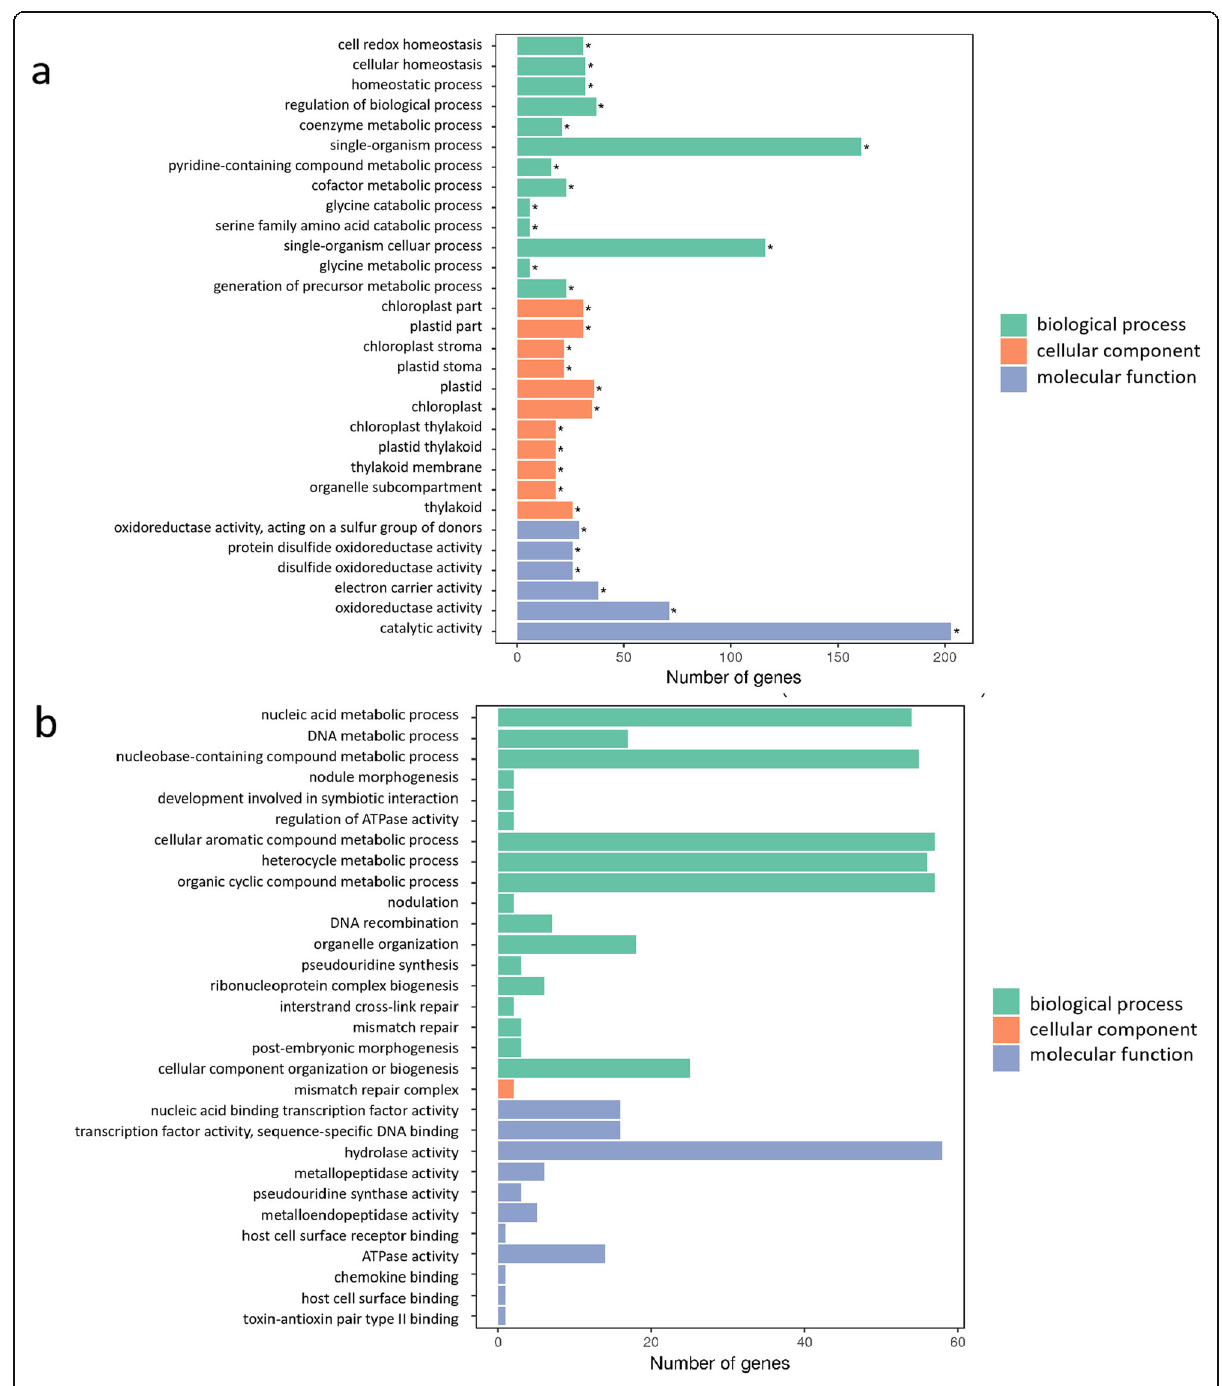
Fig. 1 Classification of gene ontology (GO) analysis of selected DEGs after inoculation with WDV. a Top 30 GO terms enriched for down-regulated DEGs. b Top 30 GO terms enriched for up-regulated DEGs. The y-axis represents the enriched GO term, and the x-axis represents the number of DEGs in the term. Different colors are used to distinguish biological processes, cellular components, and molecular functions. GO term with asterisk means significant